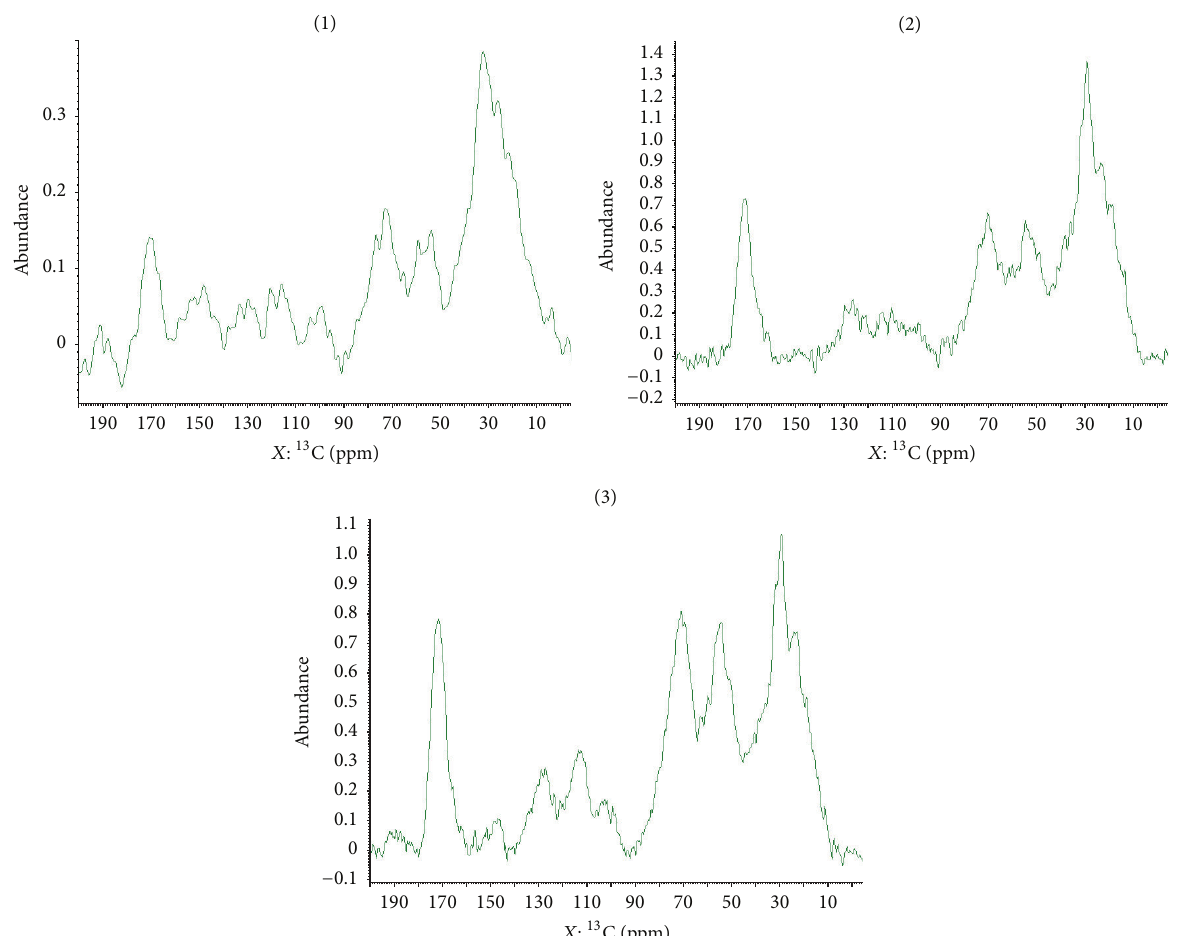
Figure 3: 13 C NMR spectra of HAs isolated from Arctic soils: buried H layer (1), uppermost A horizon Bolshoy Lyakhovsky Island (2) and A horizon, Wrangel Island (3).